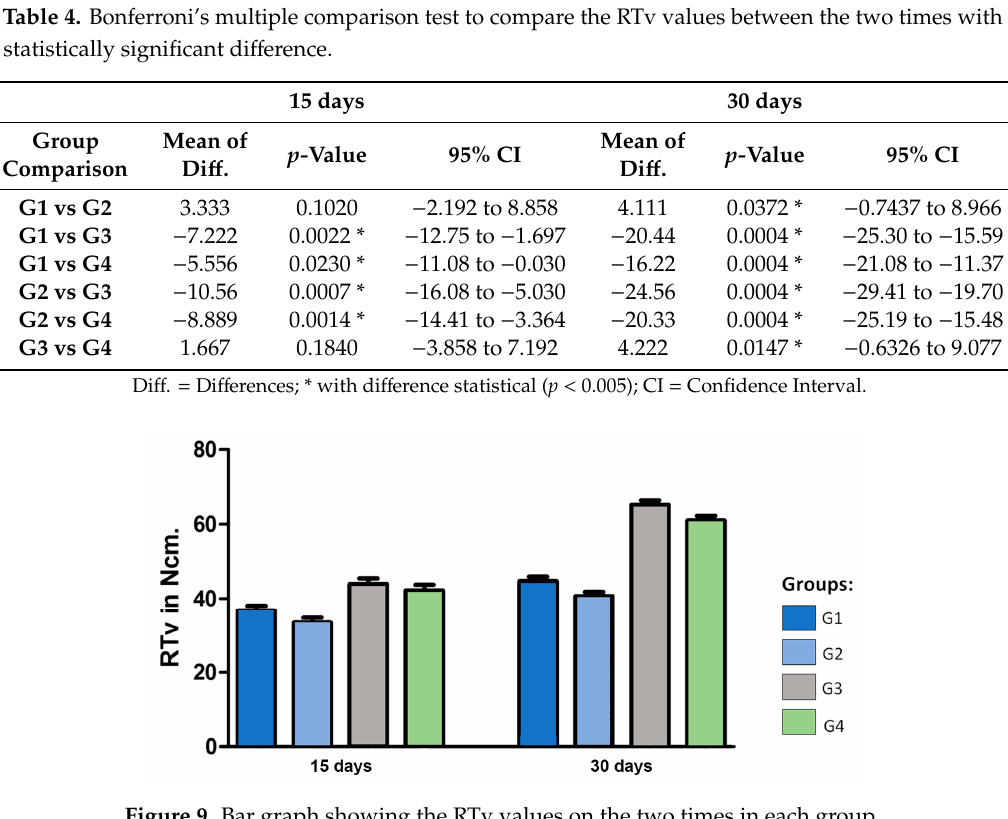
Figure 9. Bar graph showing the RTv values on the two times in each group. Table 1. Mean and standard deviation (SD) of removal torque values measured for each group in Ncm.